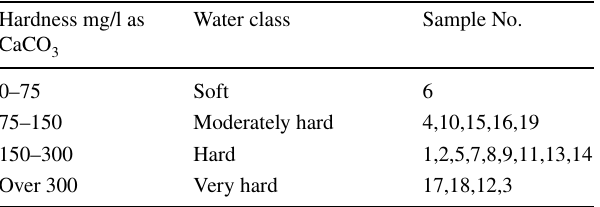
Fig. 3 Spatial distribution map of PH, Hardness, TDS and Calcium Table 3 Hardness classification of Water (After Sawyer and McCarty 1967)